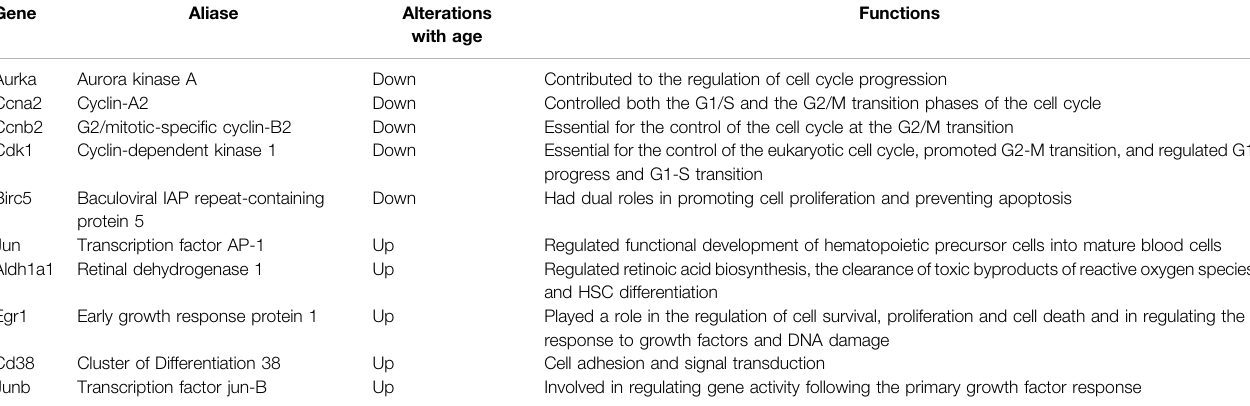
TABLE 1 | Alterations and functions of hub genes during HSC the aging process. Gene